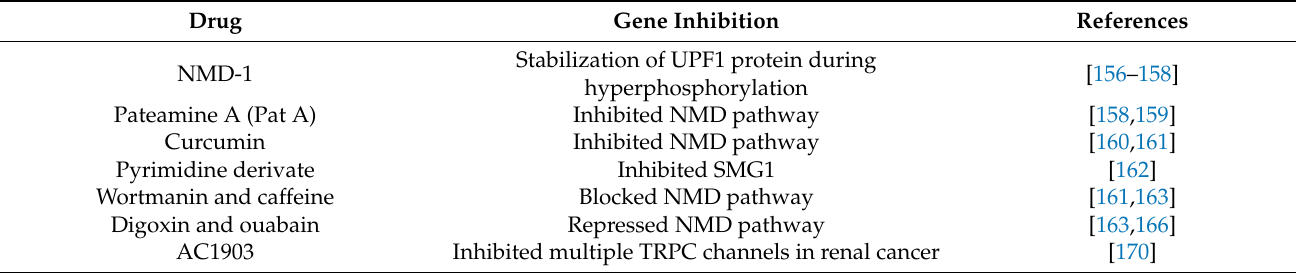
Table 3. Different NMD